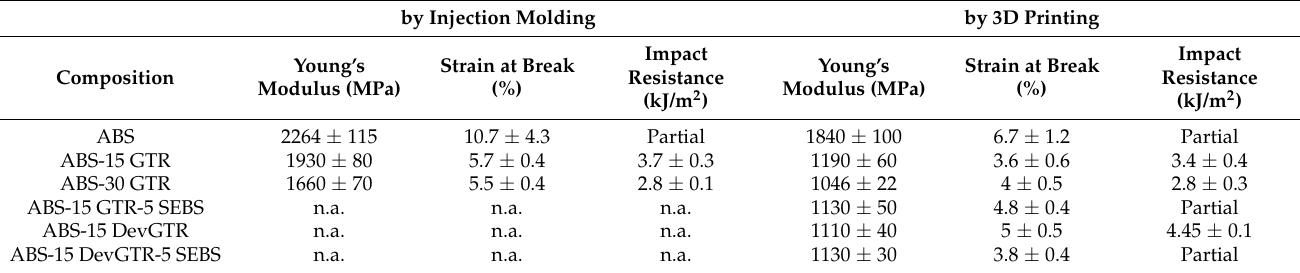
Table 4. Mechanical properties (tensile and impact tests) of ABS-based composites loaded with recycled GTR or DevGTR, containing or not compatibilizing